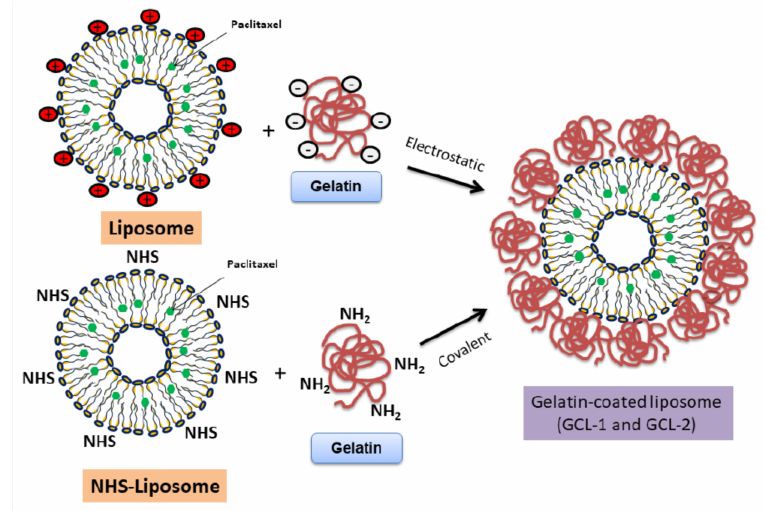
Figure 2. The mechanism of gelatin coating. Gelatin-coated liposome-1 was generated using charge interaction (GCL-1, left ). Gelatin-coated liposome-2 was produced using covalent bonding (GCL-2. right ). NHS refers to N-Hydroxysuccinimide, which readily reacts with free